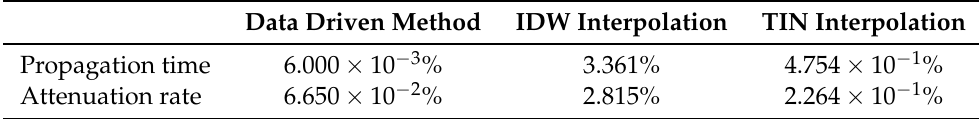
Table 4. A comparison of estimation error compared with the reference